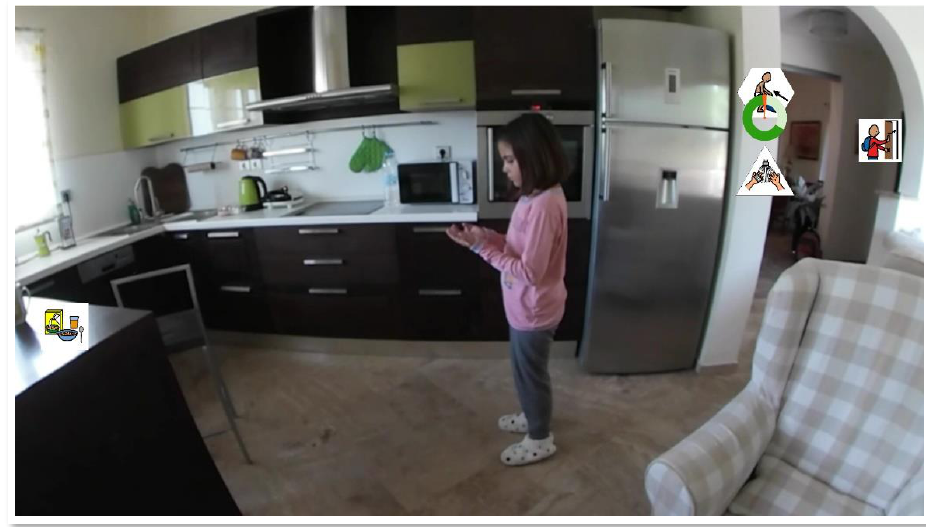
Figure 27. A hotspot being activated via a rotating indicator.